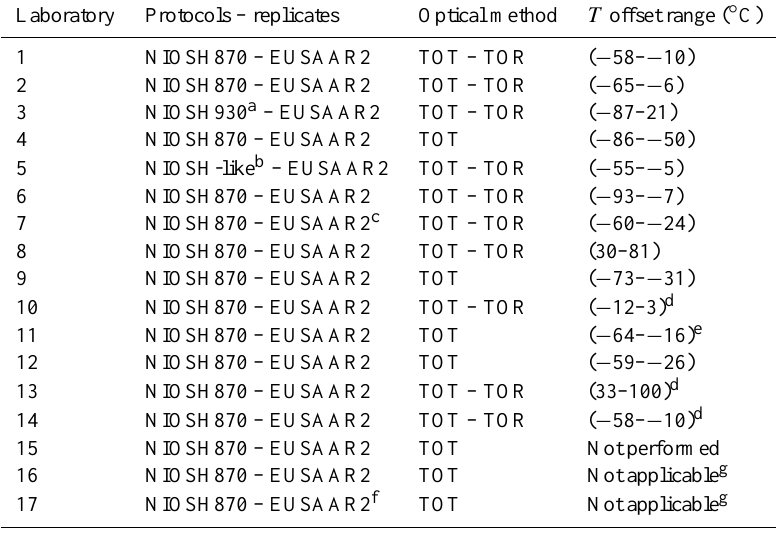
Table 3. Thermal protocols used for replicate analysis, optical method applied and temperature offset range per